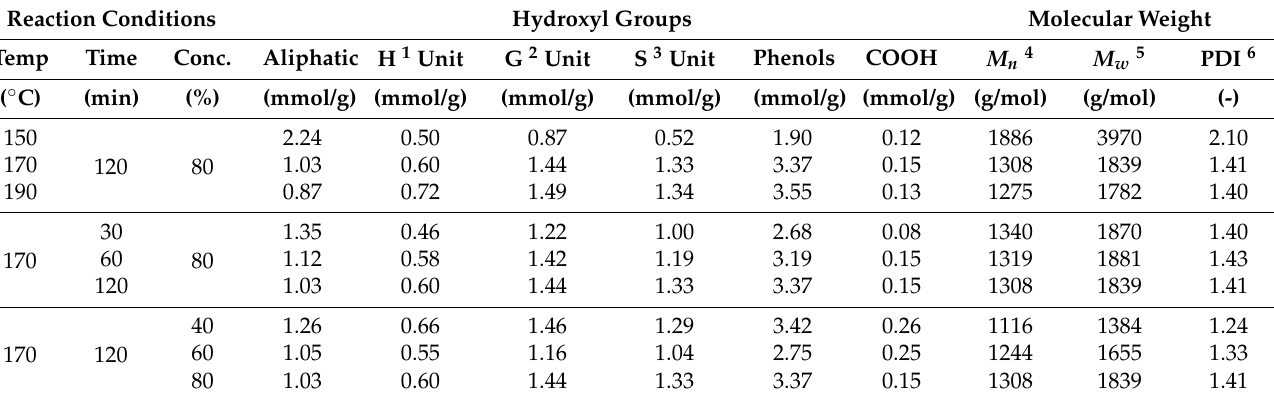
Table 4. Effects of reaction temperature, time, and ethanol concentration on hydroxyl groups and molecular weight of precipitated